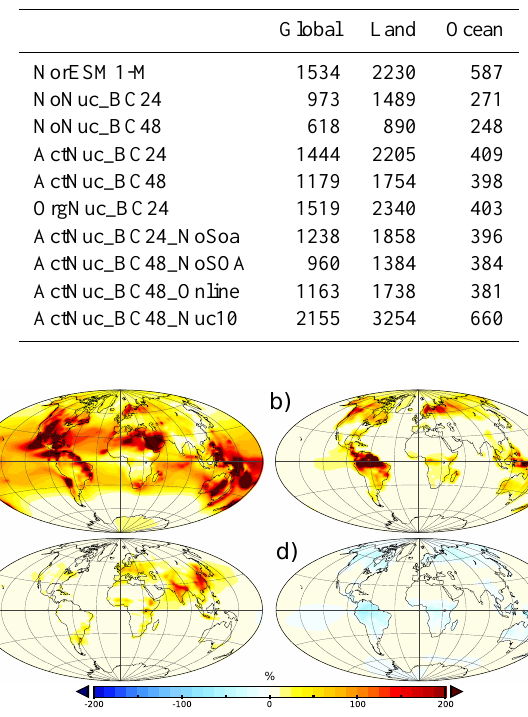
Figure 2. Surface-level aerosol number concentration differ- ence fields (%) from sensitivity simulations, due to (a)